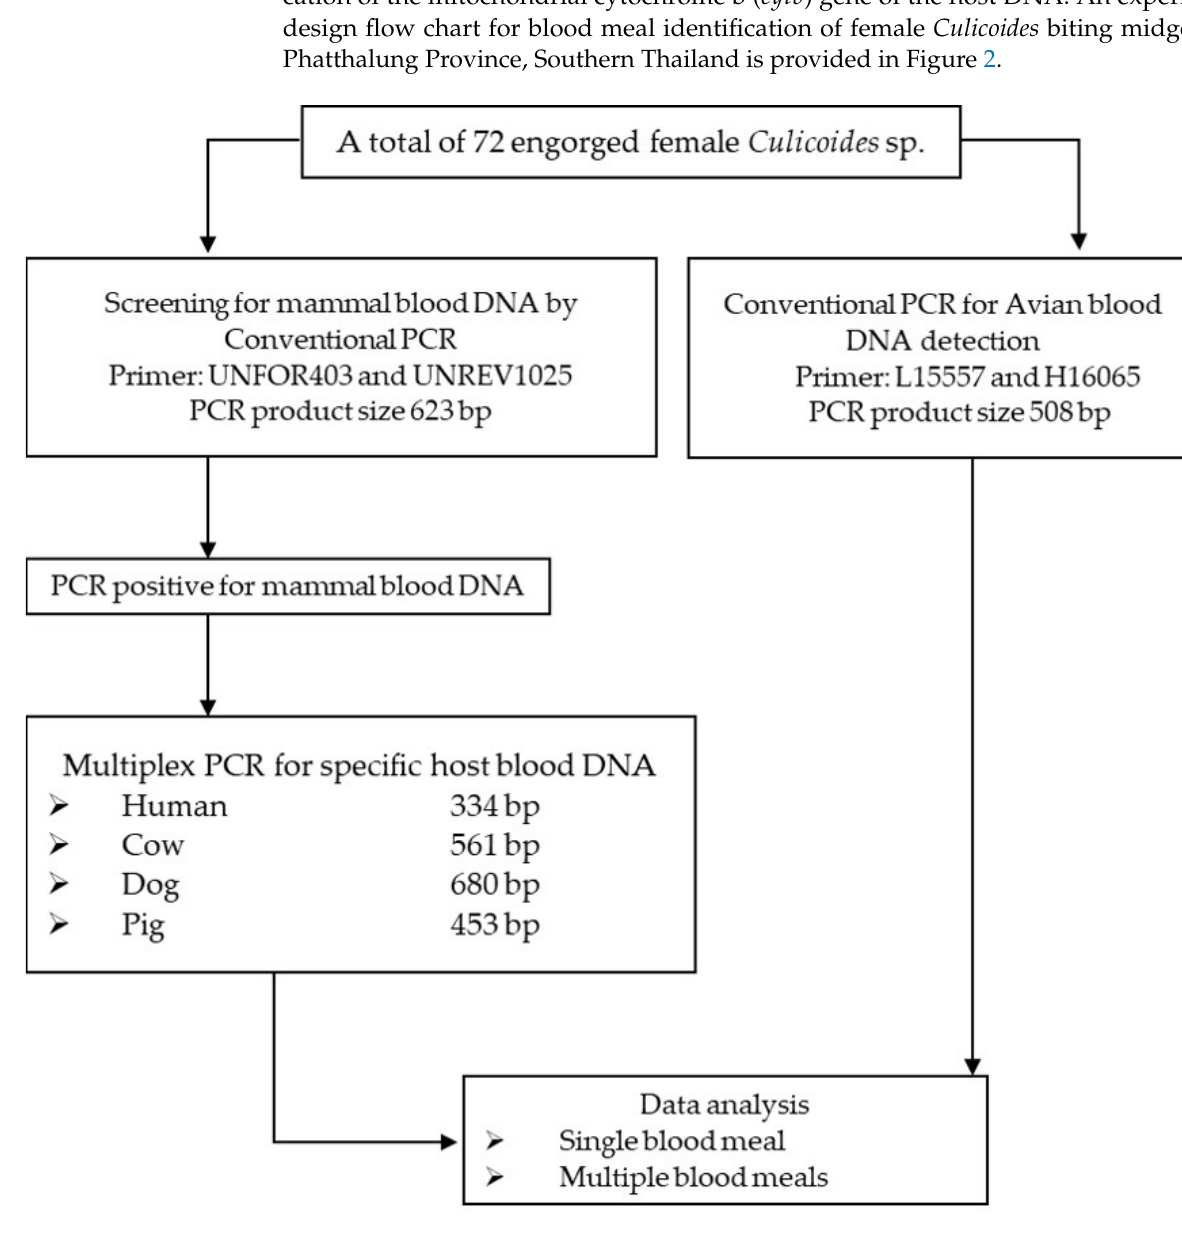
Figure 2. Experimental design for blood meal identification of female Culicoides biting midges from Phatthalung Province, Southern Thailand.